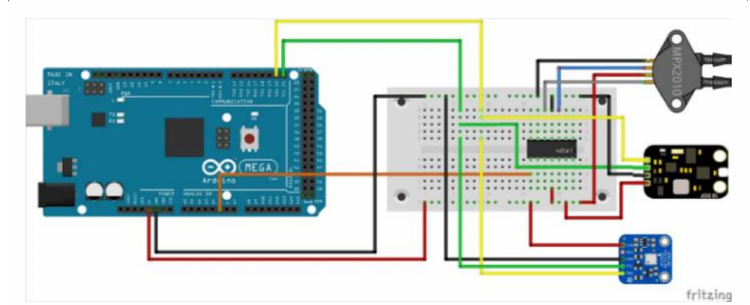
Figure 6. Electric scheme of the developed system.